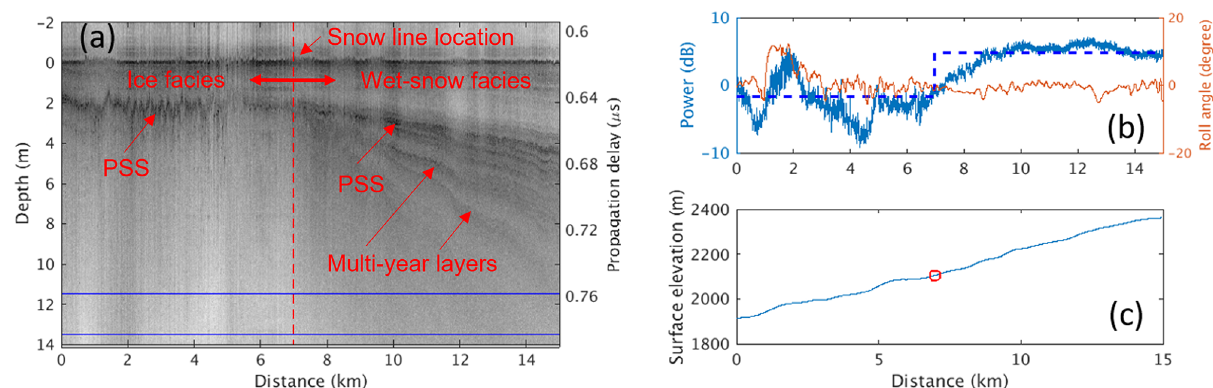
Figure 12. Snow stratigraphic features during the transition from wet-snow facies to ice facies. Table 4. Snowline locations of glaciers and ice fields. Snowline location CReSIS data frames Glacier name Latitude ( ◦